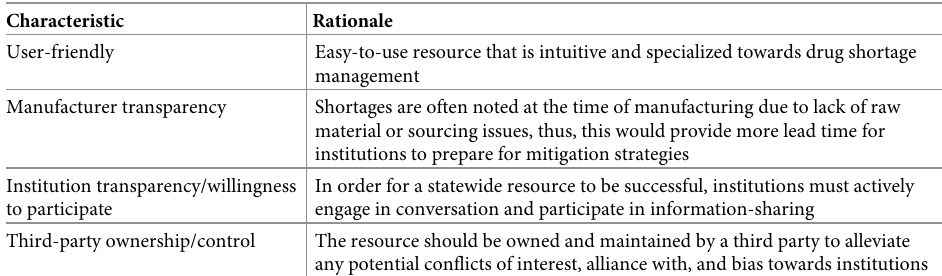
Table 2. Collaborative resource